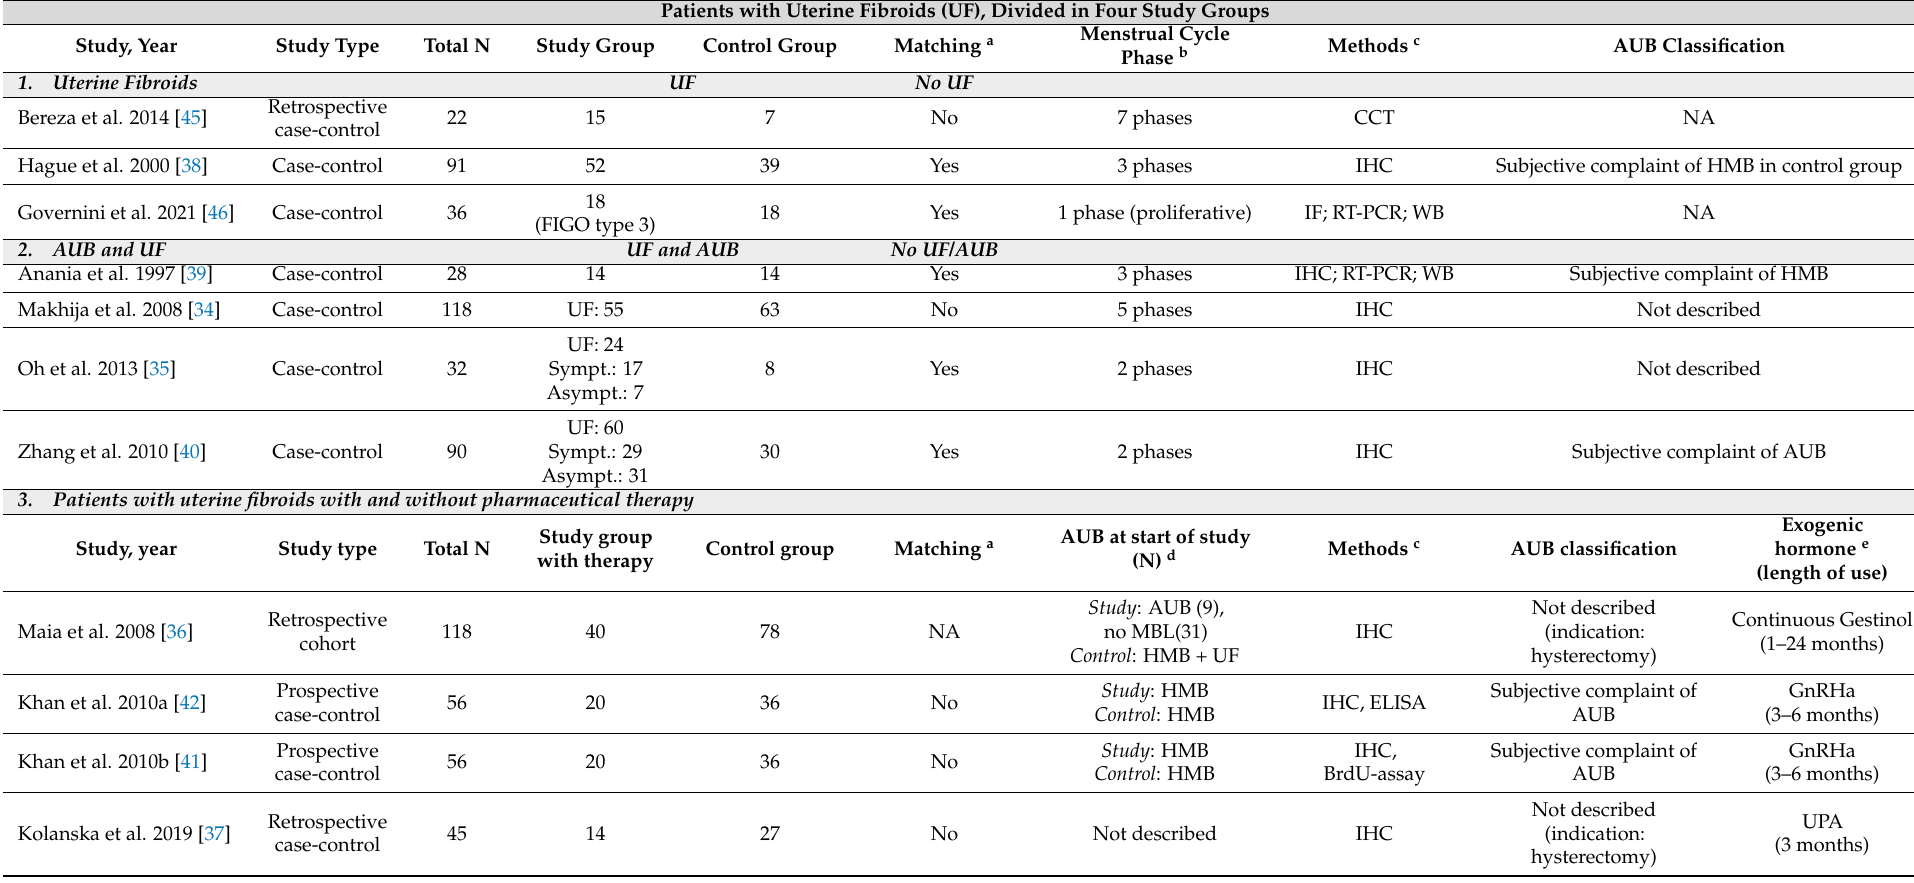
Table 3. Study characteristics of included